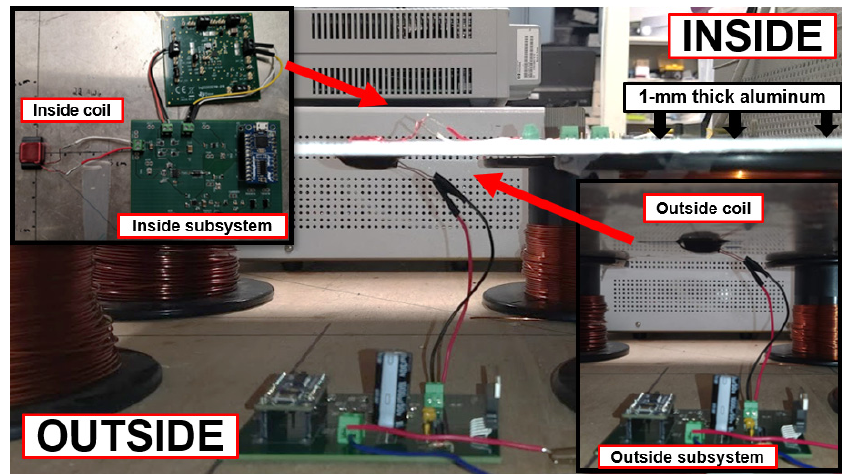
Figure 18. Test setup for through metal communication system. Below the metal plate: the coil connected to the outside subsystem. Above the metal plate: the coil and the inside subsystem. Each coil is located at the center of the 1 mm-thick aluminum plate and separated 0.5 mm away from the metal plate.